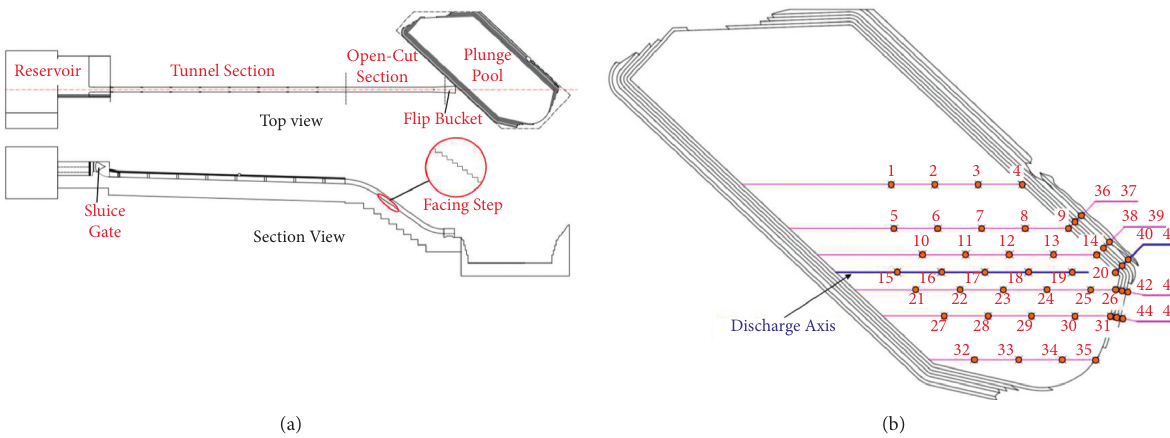
Figure 2: Layout plan of the hydraulic model test and measuring points of fluctuating pressures. (a) Layout of the hydraulic model test. (b) Measuring points diagram of fluctuating